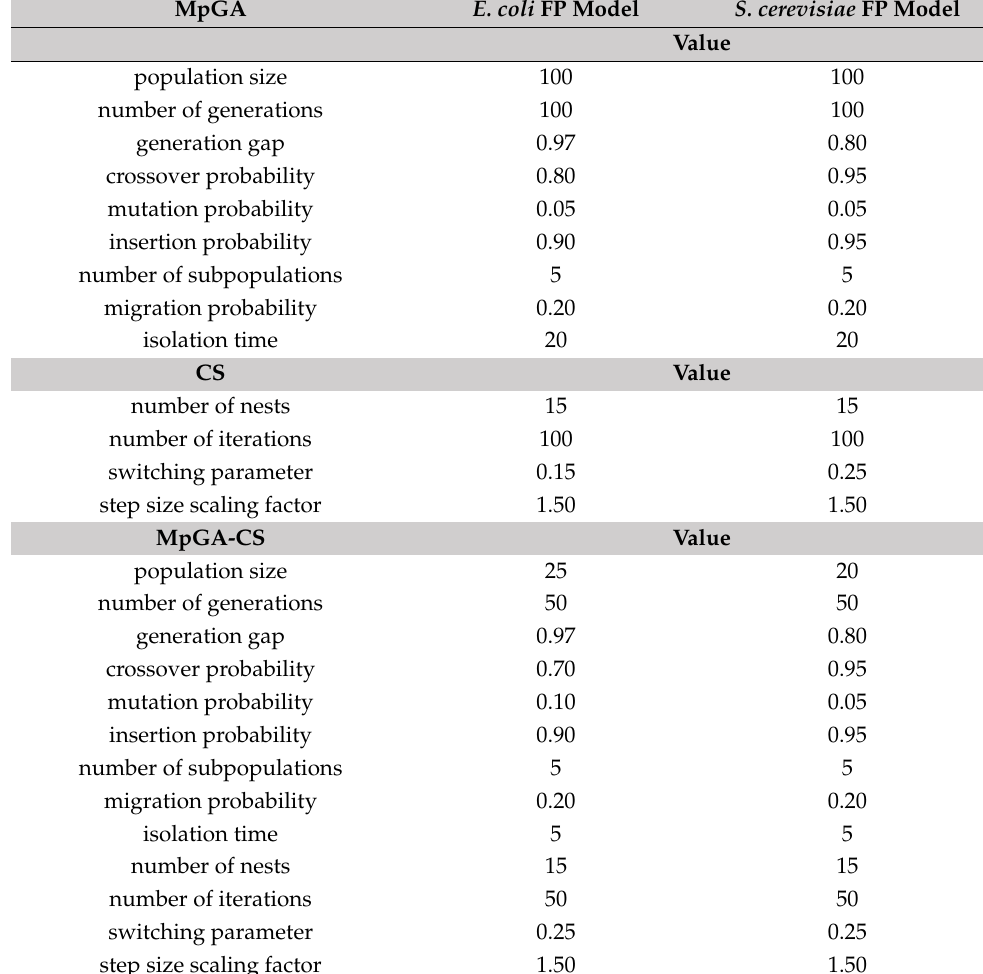
Table 2. The optimal values of the main parameters of the metaheuristic algorithms.